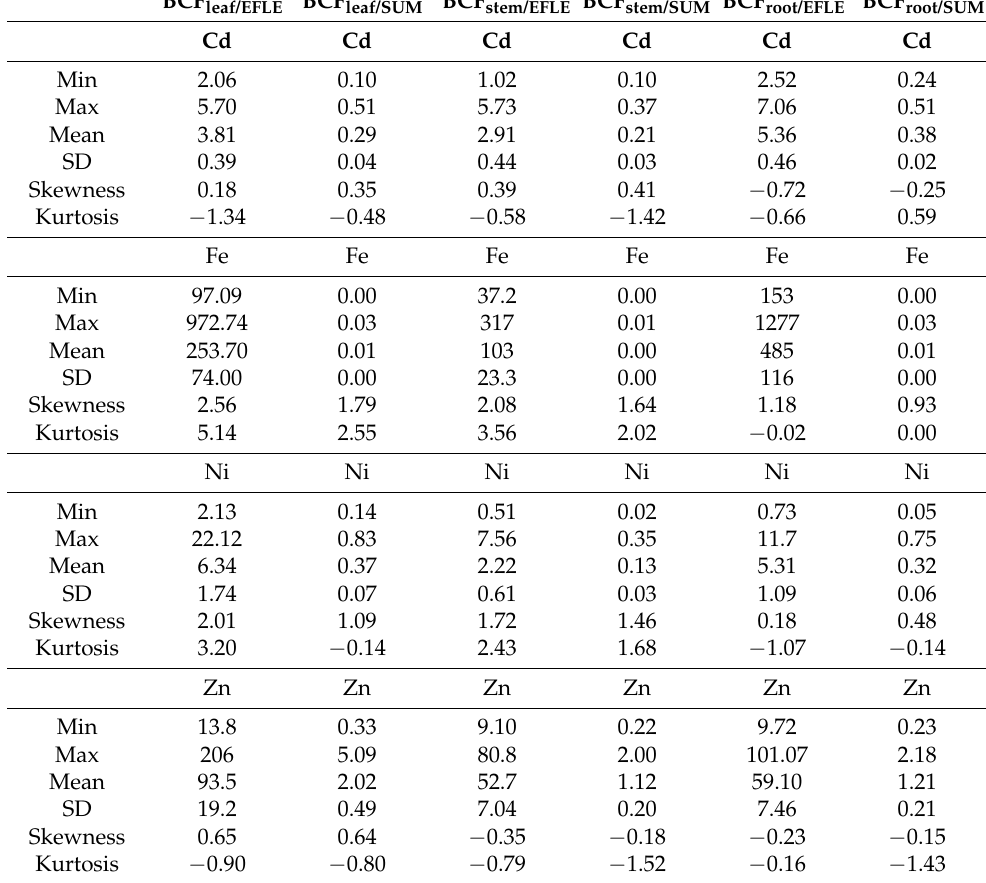
Table 6. Overall values of bioconcentration factors (BCF) of Cd, Fe, Ni, and Zn on the leaves, stems, and roots of Amaranthus viridis in Peninsular Malaysia (based on 11 sampling